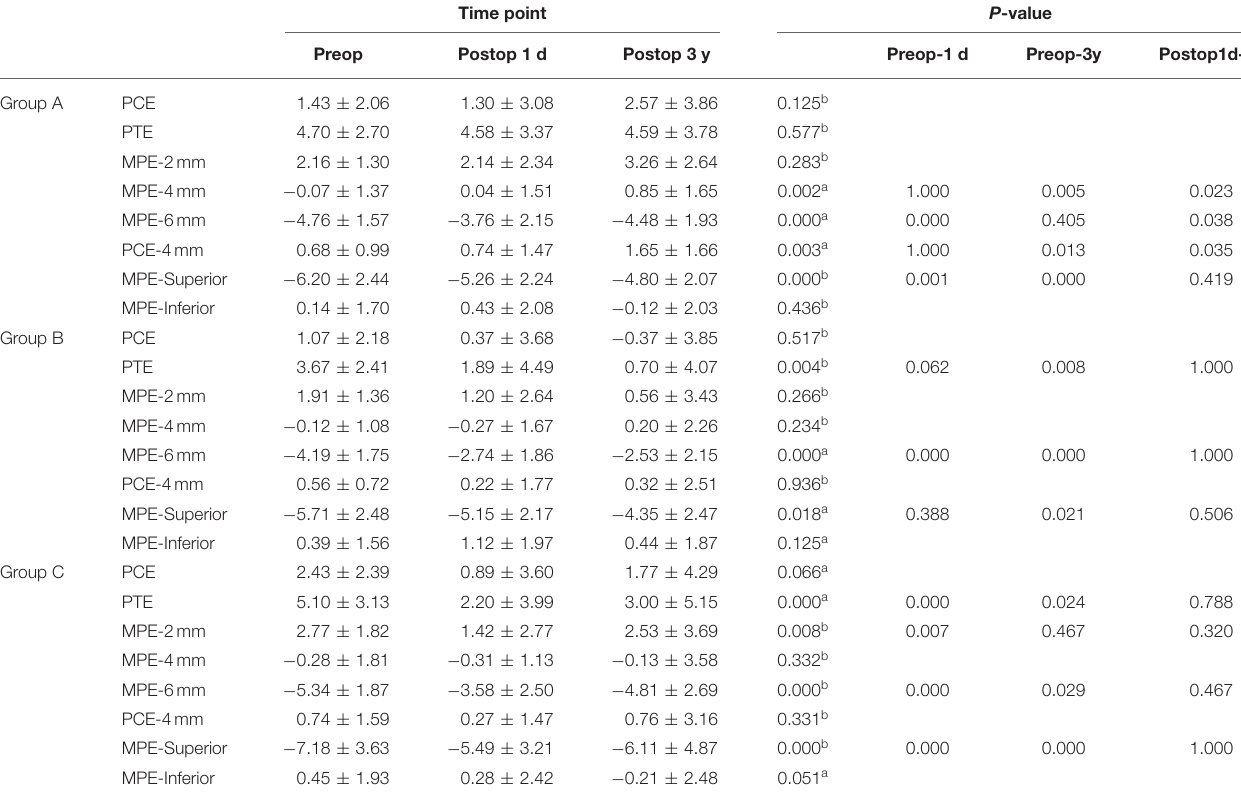
TABLE 2 | Posterior corneal elevation before and after SMILE in different groups. Time point P -value Preop Postop 1 d Postop 3 y Preop-1 d Preop-3y